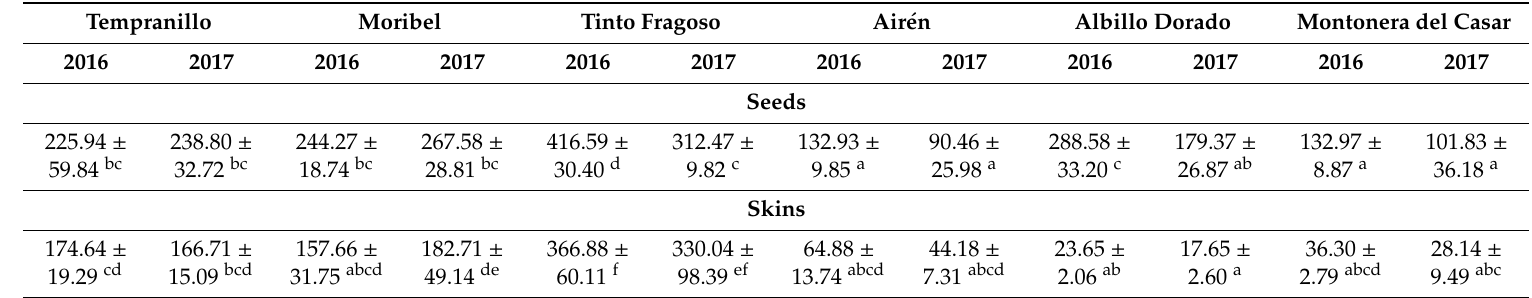
Table 1. Total monomeric flavanol monoglycosides (MMG) of skin and seed extracts from Vitis vinifera grape varieties (mean value ± standard deviation, n = 3), µ g / kg of grape